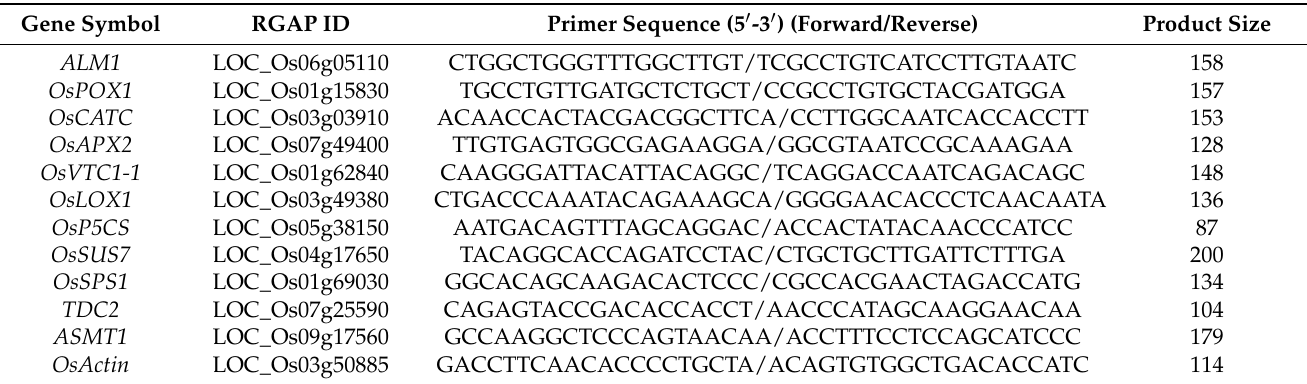
Table 1. qRT-PCR primers used for gene expression